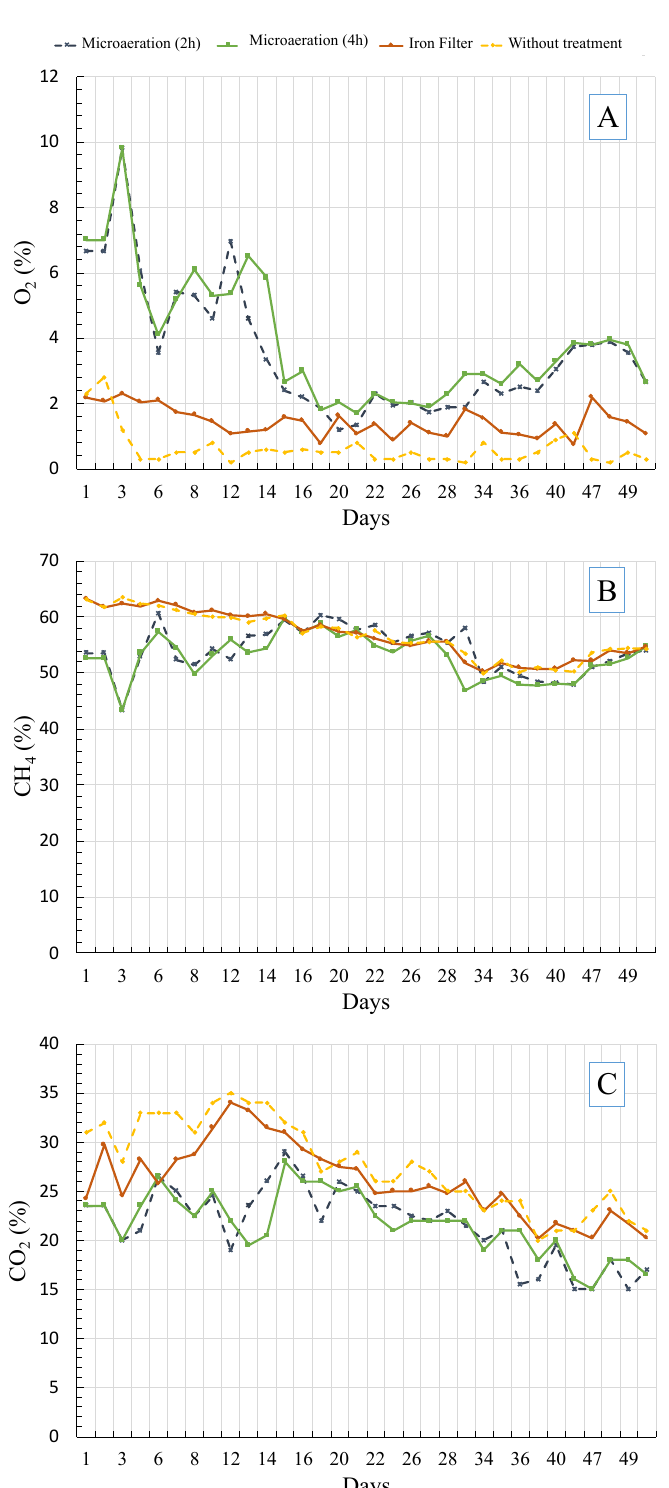
Figure 3. The concentrations of O 2 ( A ), CH 4 ( B ), and CO 2 ( C ) in the biogas over 50 days showing concentrations pre-treatment, with iron filter H 2 S removal and microaeration.